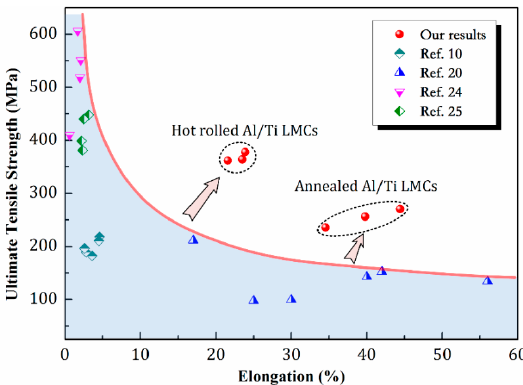
Figure 12. Comparison of ultimate tensile strength and total elongation of Al / Ti LMCs combination between the present investigation and previous references.